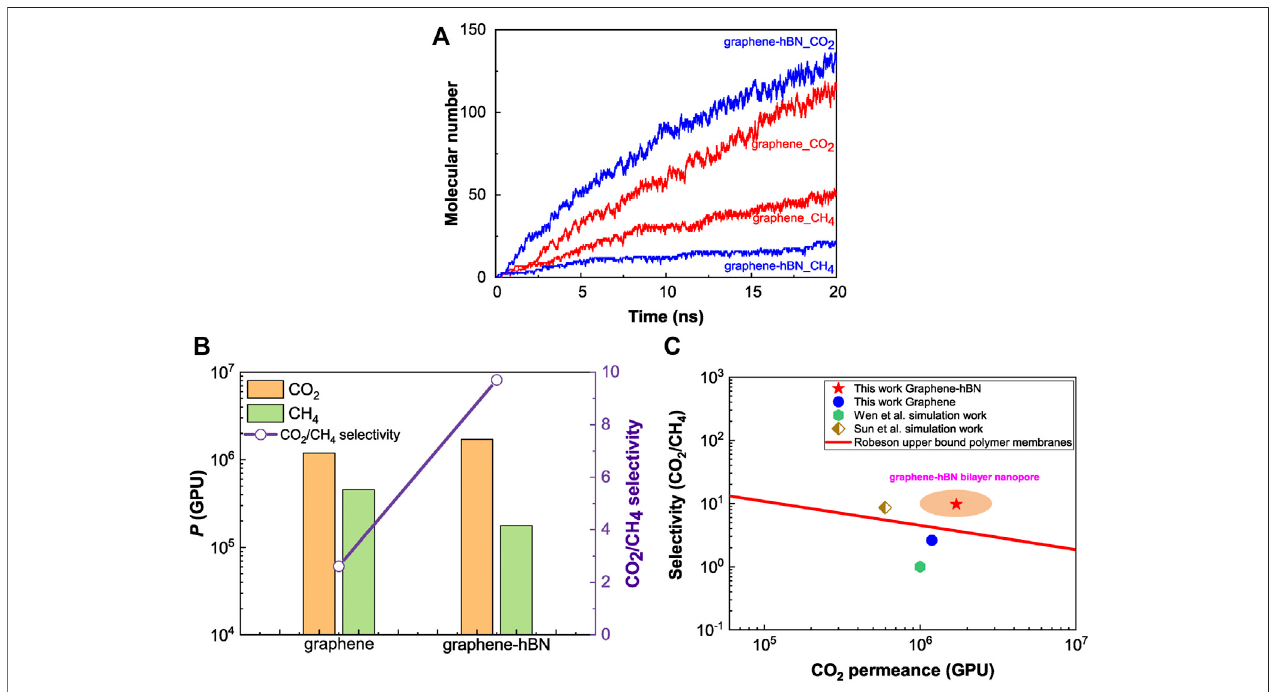
FIGURE 2 | CO 2 /CH 4 separation performance of nanopores. (A) Time-variation of the number of permeated molecules for the separation of CO 2 /CH 4 ; (B) comparison of the molecular permeance and selectivity; (C) comparison with existing simulation data in literature (Wen et al., 2015; Sun and Bai, 2017).